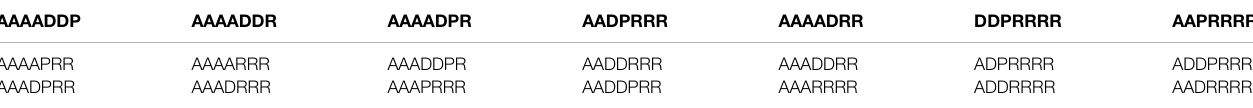
TABLE 1 | Pharmacophoric variant listing 21 out of 21 were selected, where the highest and lowest amount of positions are 7 and 4 correspondingly.